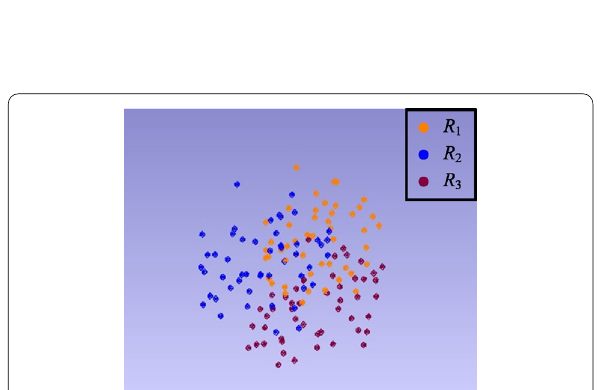
Figure 10 Measured data of the parallel manipulator in the DAQ software